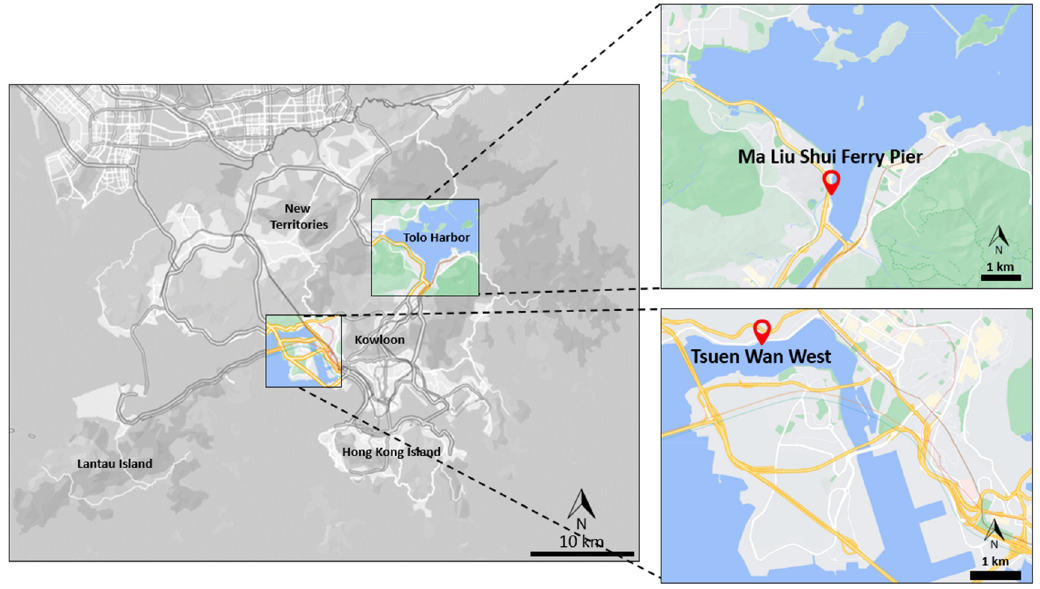
Figure 3. Environmental water sampling locations for MPs survey at Ma Liu Shui Ferry Pier and Tsuen Wan West, Hong Kong.